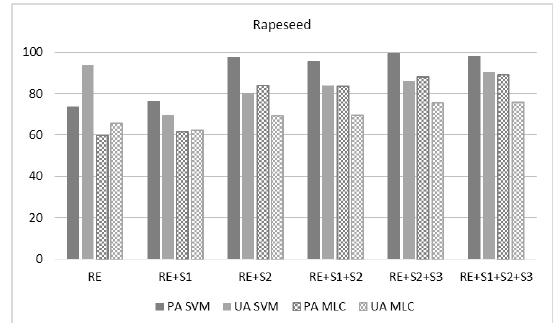
Figure 4. Producer´s and user´s accuracies for rapeseed for all image combinations